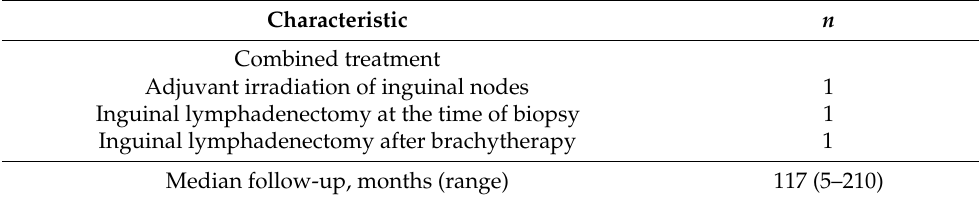
Table 1. Cont . Characteristic n Combined treatment Adjuvant irradiation of inguinal nodes Inguinal lymphadenectomy at the time of biopsy Inguinal lymphadenectomy after brachytherapy Median follow-up, months